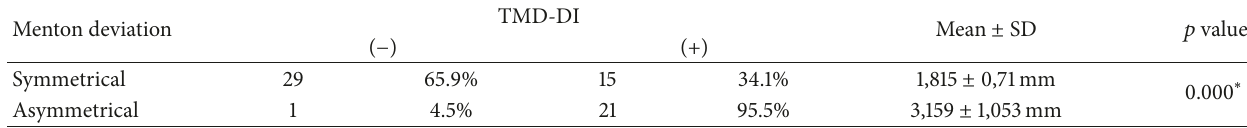
Table 2: Correlation of menton deviation horizontally to TMDs group (unpaired 𝑡 -test).